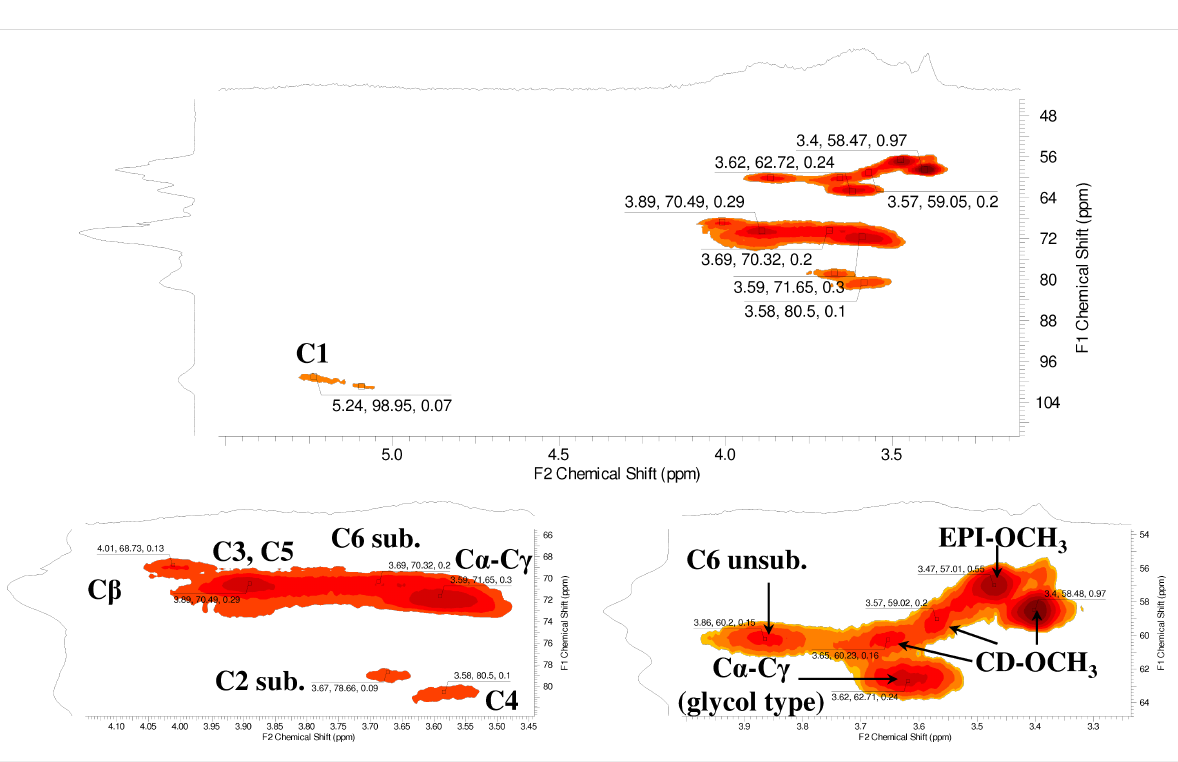
Figure 4: HSQC-DEPT spectra of compound 4 with partial assignment; in the upper part the full spectrum is shown and on the bottom some regions are